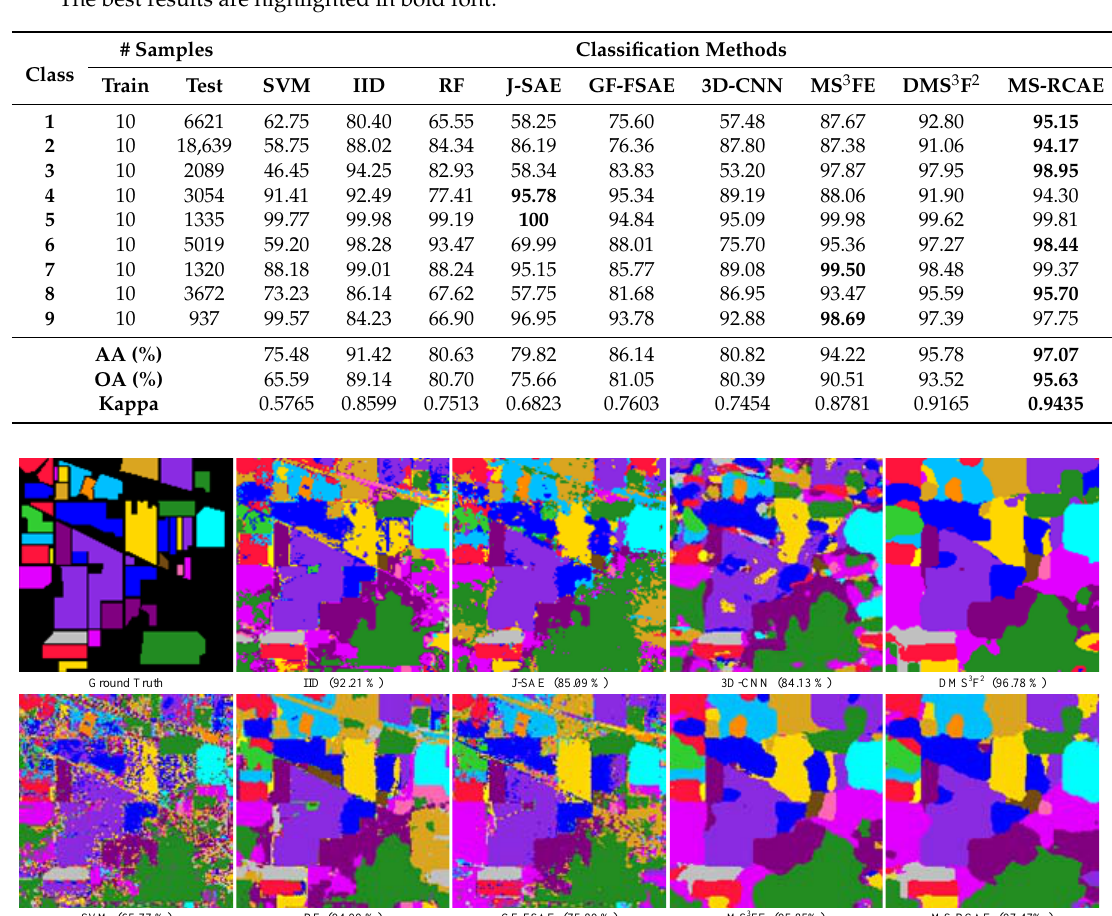
Table 2. Classification accuracies of University of Pavia dataset obtained by each comparison methods. The best results are highlighted in bold font.